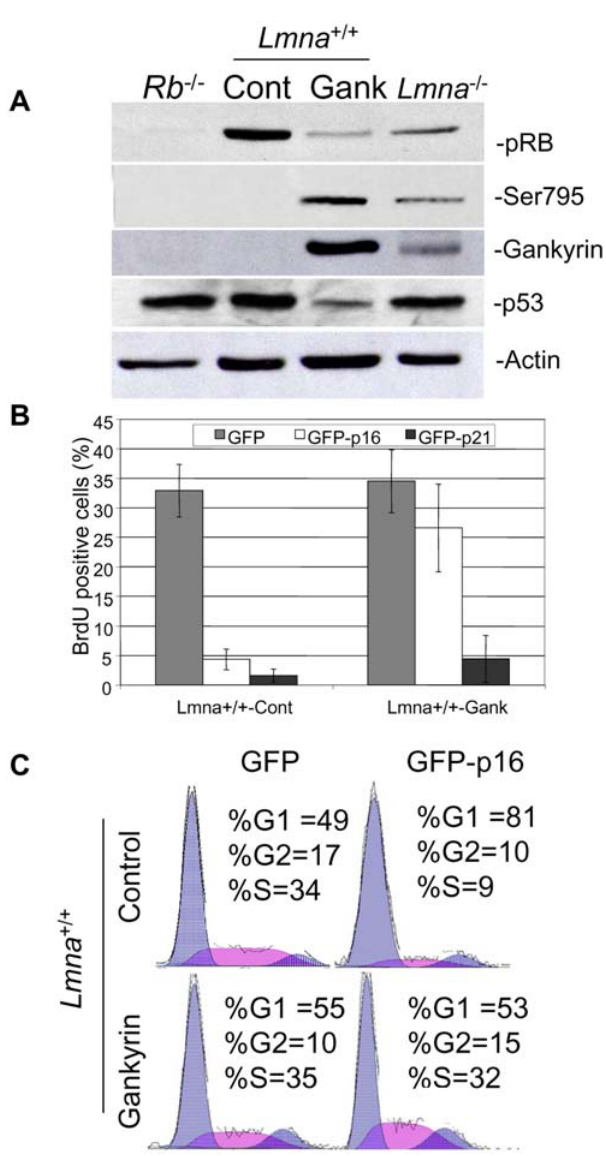
Figure 3. Overexpression of gankyrin reduces pRB levels and makes Lmna + / + cells refractory to p16 ink4a -induced arrest . (A) Western analysis of Lmna + / + infected with a control plasmid, Lmna + / + -Cont, or gankyrin, Lmna + / + -Gank, and uninfected Lmna 2 / 2 fibroblasts. Rb 2 / 2 fibroblasts were included as a control for pRB levels. (B) Cells were transfected with GFP-p16 ink4a or GFP-p21 cip1 and GFP-positive cells were scored; S-phase cells were identified by BrdU incorporation. The percentage of cells positive for GFP and BrdU incorporation were quantified. Results are shown with standard deviations from triplicate samples; 150 cells were counted per sample. (C) Flow cytometry was conducted on Lmna + / + -Cont and Lmna + / + -Gank cells transfected with GFP or GFP-p16 ink4a